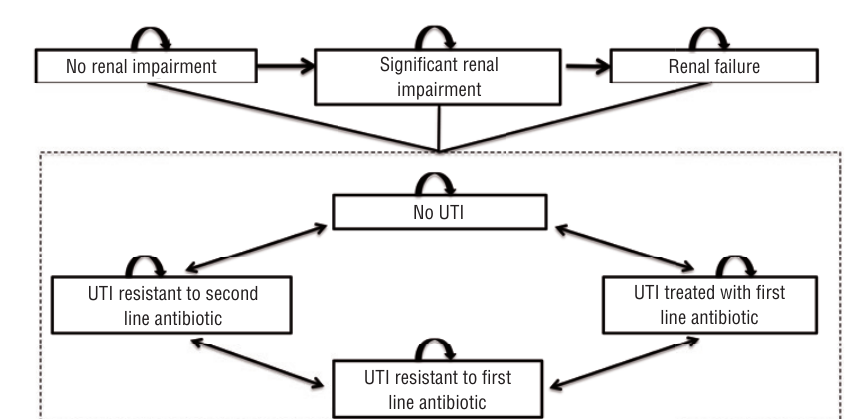
Figure 1 – Markov decision model – three renal stages and four urinary tract infection (uTI) levels regardless the impairment of renal